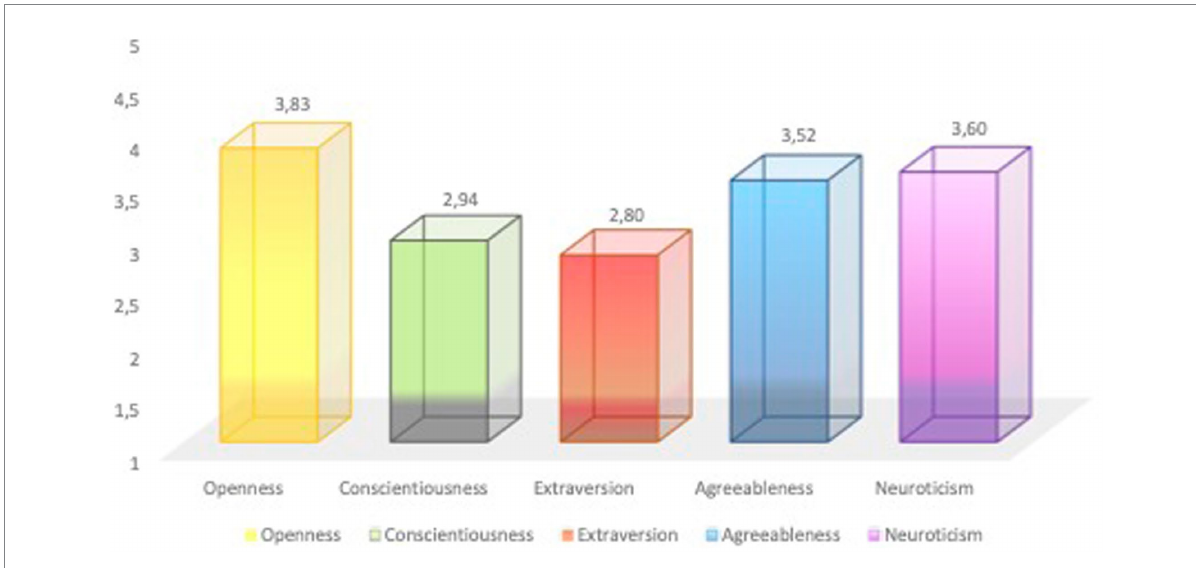
FIGURE 2 The levels of personality domains captured by the Big Five Inventory among gender non-binary adolescents ( N =